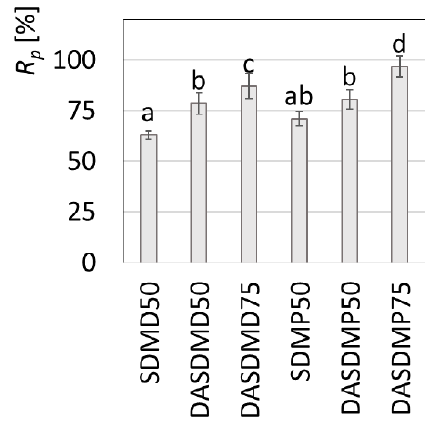
Figure 1. Powder recovery ( R p ) after conventional spray drying (SD) and dehumidified-air-assisted spray drying (DASD) of buckwheat honey solutions containing 50 and 75% honey solids and maltodextrin (MD) or milk powder (MP) as carriers. a–c The differences between mean values with the same letter in rows are statistically insignificant ( p < 0.05).